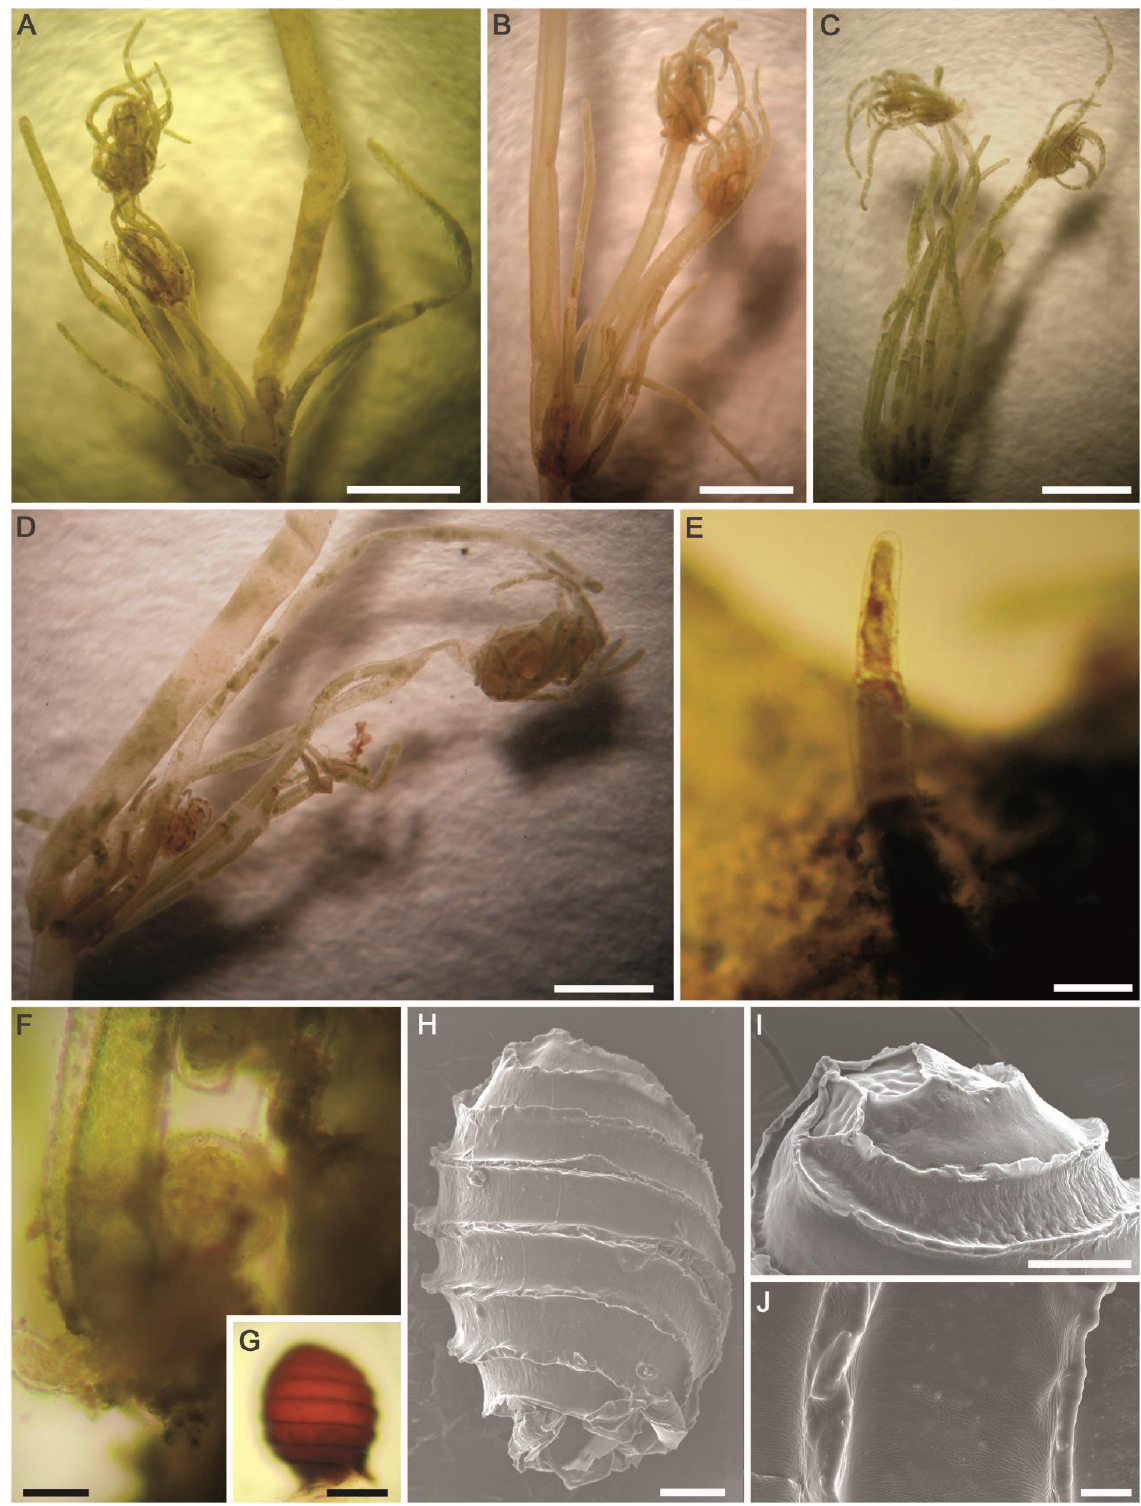
Figure 13. Morphotaxonomic features of Tolypella sp. PBA – 1704 from a desert, freshwater wetland in the El-Dakhla Oasis (the Western Desert of Egypt): ( A – D ) macroscopic habitus; ( E ) fertile branchlet with cylindrical obtuse end cell; ( F ) branchlet node with gametangia; ( G ) oospore; ( H ) SEM of oospore showing flanged ridges; ( I ) apical view of oospore; ( J ) close-up SEM view on the oospore wall depicting smooth ornamentation of fossa and ridges. Scale bars: ( A – C ) = 3 mm; ( D ) = 2 mm; ( E , G ) = 100 μ m; ( F , H , I ) = 50 μ m; ( J ) = 10 μ m.